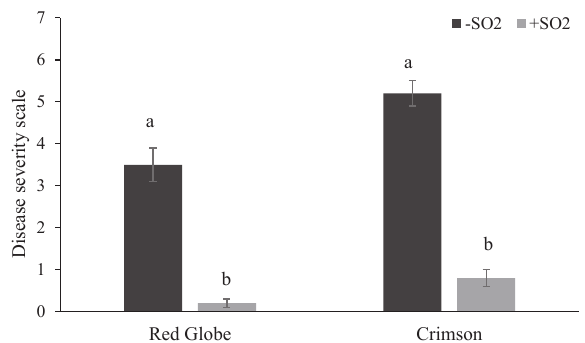
Figure 3. Disease severity (scale 0-7) on ‘Red Globe’ and ‘Crim- son’ table grapes, stored either with (+SO 2 ) or without (black his- tograms, -SO 2 ) SO 2 pads, after three month of storage. Columns accompanied by different letters are significantly different ( P ≤0.05). Bars represent standard errors of means, each from three